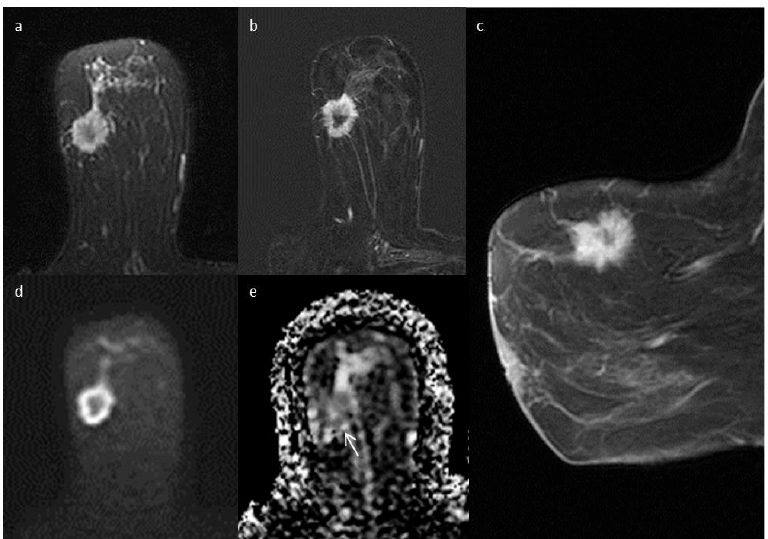
Figure 1. Standard breast MRI protocol. ( a ) axial fat ‐ suppressed T2 ‐ weighted sequence shows a dishomogeneous, hyperintense mass with spiculated margins and a thin layer of perilesional edema, in the upper ‐ outer quadrant of the right breast; ( b ) axial subtracted image and ( c ) sagittal post ‐ Gadoteridol T1 ‐ weighted sequence show a corresponding irregular ‐ shaped mass with spiculated margins of about 30 mm in size, characterized by heterogeneous enhancement; ( d ) axial DWI (b value = 1000 s/mm 2 ) and corresponding ( e ) ADC map show the area of restricted diffusion (arrow). The finding was classified as BI ‐ RADS 5 by both readers. Histology confirmed that the mass was an invasive carcinoma of no special type, G3, pT2, Luminal B at immunohistochemistry.